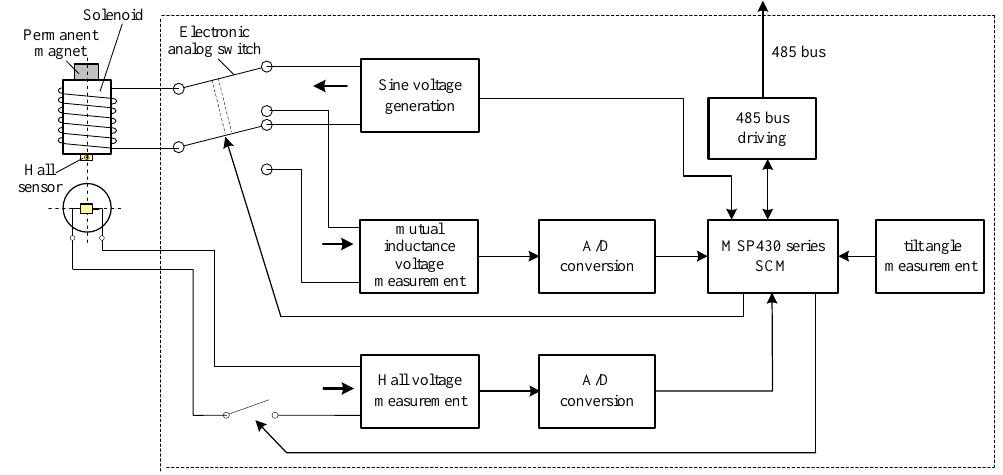
Figure 3. Sensing unit component